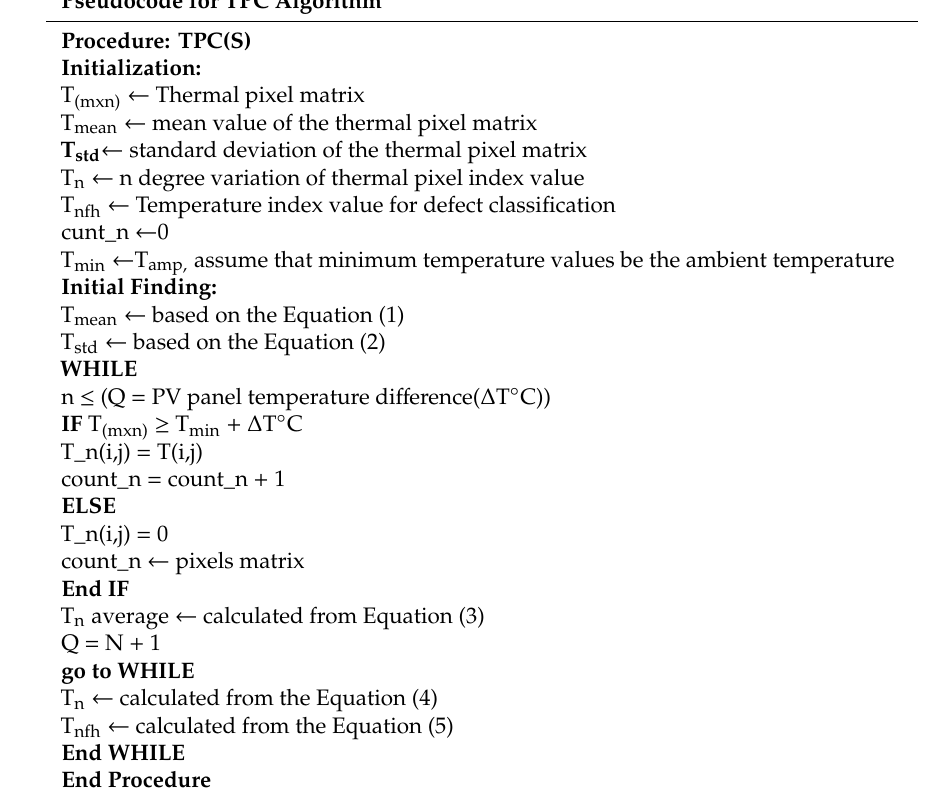
Figure 4. Flow chart for the proposed TPC algorithm. Table 5. Pseudocode for TPC Table 4. Mean and std of the temperature matrix of the PV panel and cell.